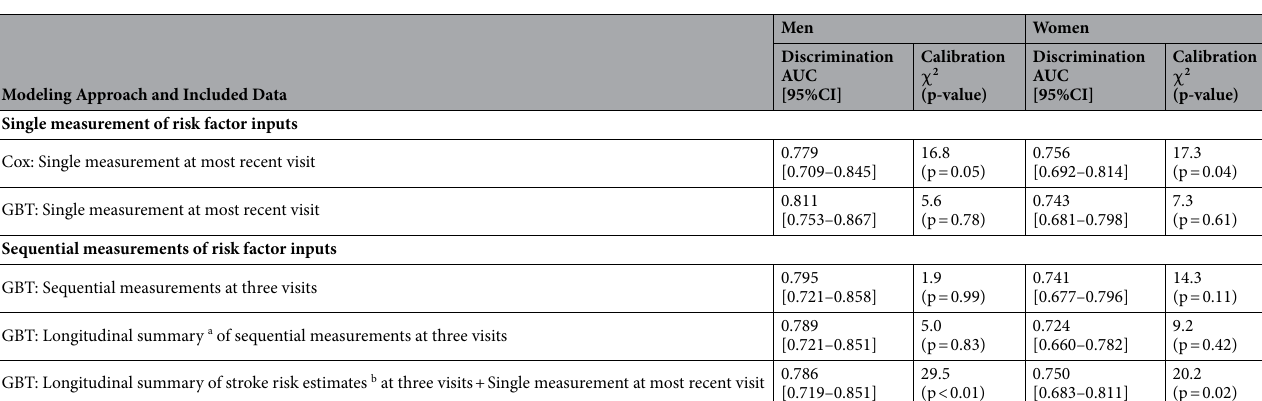
Table 2. Comparison of discrimination and calibration performance for prediction of 3-year risk of stroke using Cox and Gradient Boosted Tree (GBT) modeling approaches. a Longitudinal summary of risk factor inputs included (i) mean, standard deviation, minimum, and maximum values recorded for continuous risk factor inputs, and (ii) mean and standard deviation for binary risk factor inputs. b Longitudinal summary of risk estimates included individual-level random slopes and random intercepts from linear mixed effects models; variance of Cox-generated risk estimates across three visits; and absolute changes in Cox-generated risk estimates between consecutive